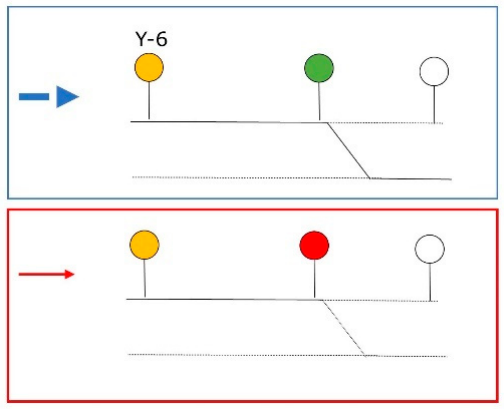
Figure 7. The yellow aspect in the deviating approach (bottom) is at the same location as the yel- low:number aspect during the standard approach because of the upcoming switch (top). For both approaches the cue is visually similar (yellow vs. yellow:number) and the location is the same.